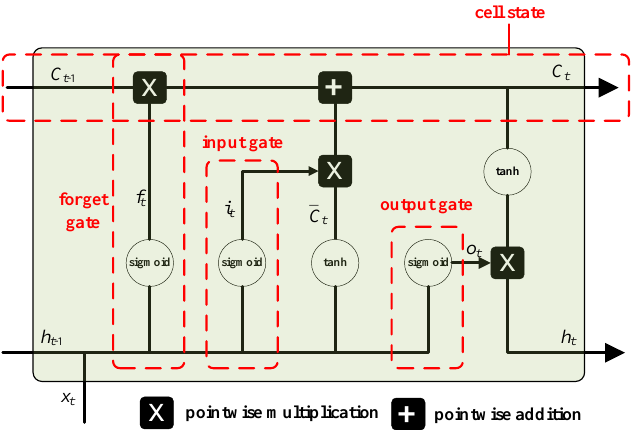
Figure 5. LSTM network structure.